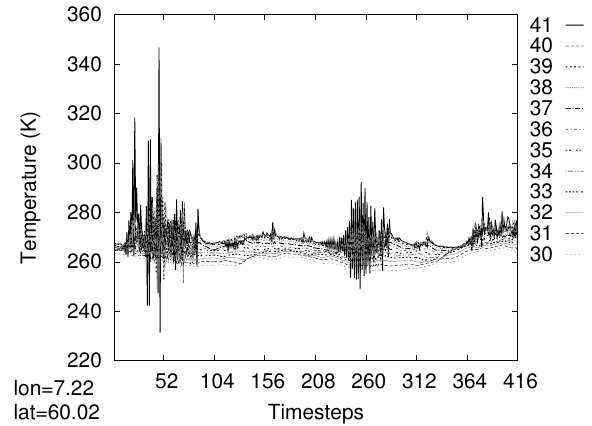
Fig. 6. The amplitude of 2∆ t temperature oscillations on the lowest model level (in Kelvin) after 96h forecast, computed according to Eq. (9) for the model run with the fibrillation amplification test of the large-scale precipitation scheme.